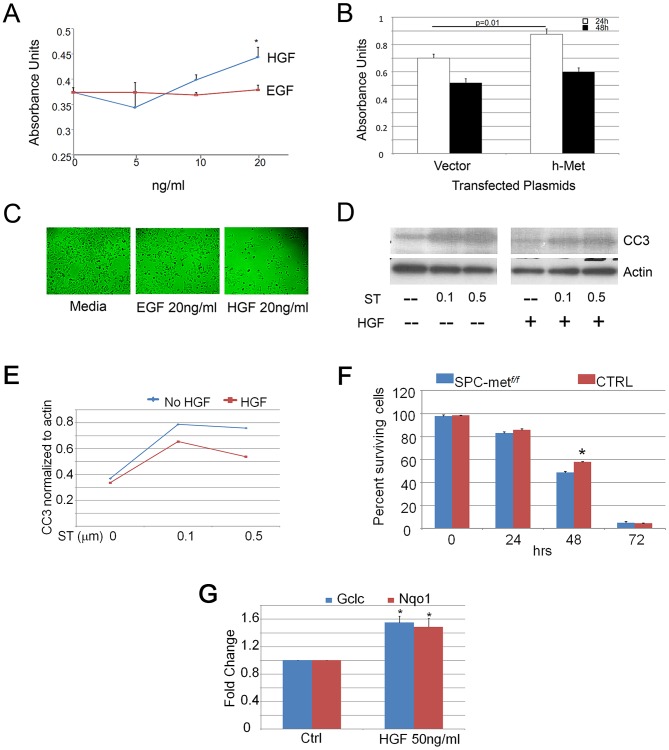
HGF signaling induces proliferation and scattering of MLE12 cells.A. Proliferation dose response of HGF and EGF treatment of MLE12 cells demonstrating a significant induction of proliferation by HGF. *p<0.05. B. Proliferation response of MLE12 cells transfected with MET or a control vector showing increased proliferation resulting from MET transfection. C. Cell dispersion images of MLE12 cells treated with EGF or HGF compared to media control. D. Effect of HGF treatment on staurosporine induced caspase 3 cleavage. ST-staurosporine. All cell experiments performed in triplicate. CC3-cleaved caspase 3. E. Densitometric quantitation of effect of HGF treatment on staurosporine induced caspase 3 cleavage. F. Survival time-course of primary alveolar epithelial cells from control and Met-deficient mice. *p<0.05. G. Relative expression of Gclc and Nqo1 with HGF treatment of primary murine alveolar epithelial cells. *p<0.05 compared with control conditions.